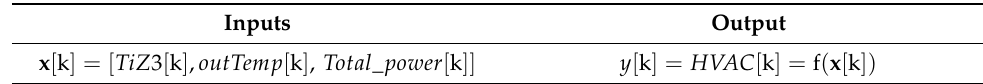
Table 2. Input–output pair of Experiment 1.